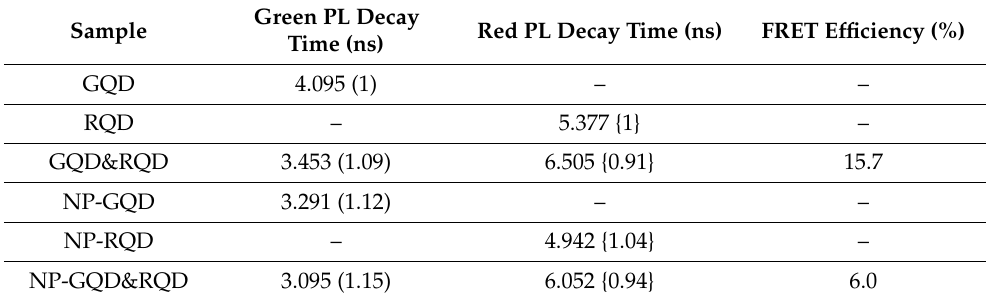
Figure 13. PL decay profiles of green and red lights in all samples under study. Table 2. PL decay times of green and red lights, and the FRET efficiencies in the samples under study. The numbers within parentheses and curly brackets show the inverse ratios of the square roots of PL decay times with respect to individual normalization base in each column.